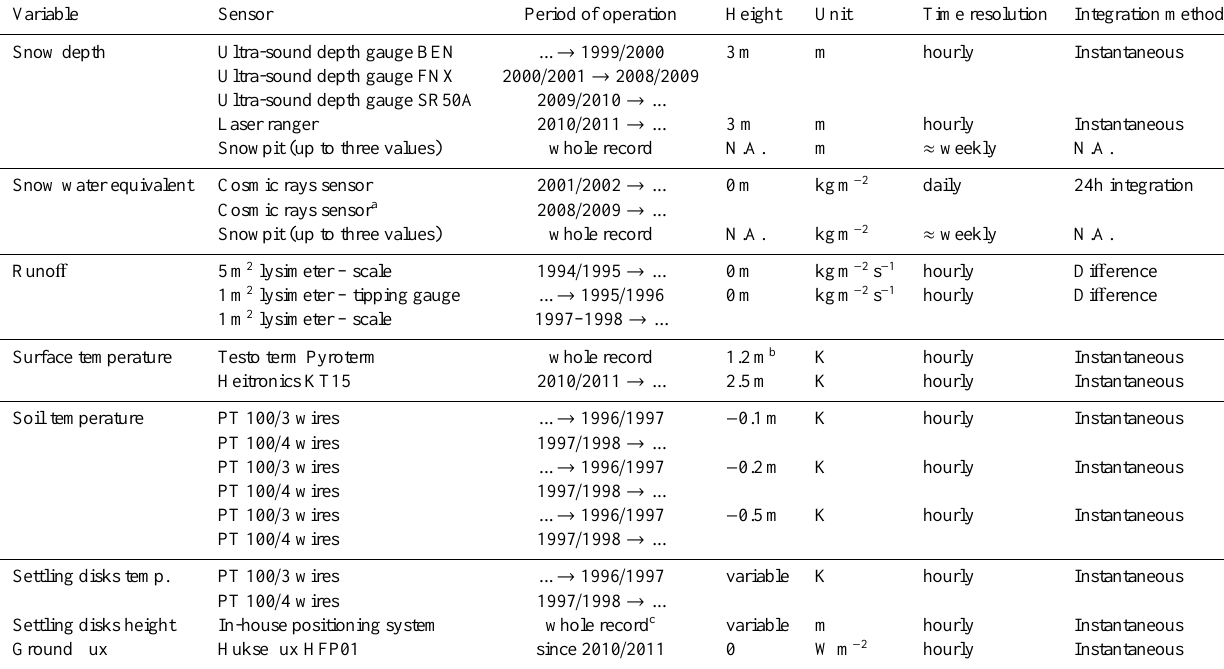
Table 2. Overview of the sensors used to gather the hourly and daily snow data used to evaluate snowpack models, between 1993 and 2011 at Col de Porte, France. Note that outgoing shortwave and longwave radiation is measured using instruments similar to the corresponding incoming radiation, described in Table 1. Note also that snow surface temperature can be derived from the outgoing longwave radiation sensor, in addition to the sensors presented